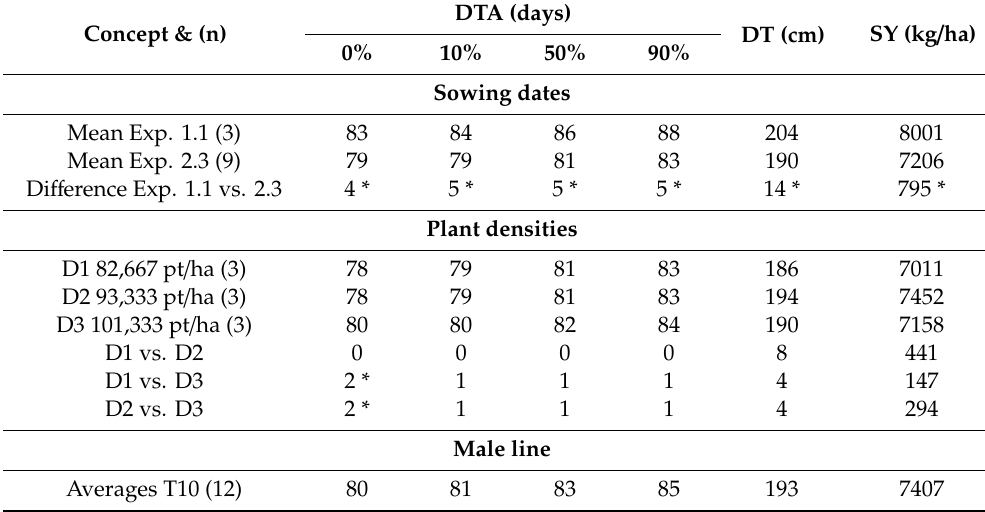
Table 3. Means and orthogonal contrasts of agronomic traits of the male line T10 for sowing dates and plant densities.